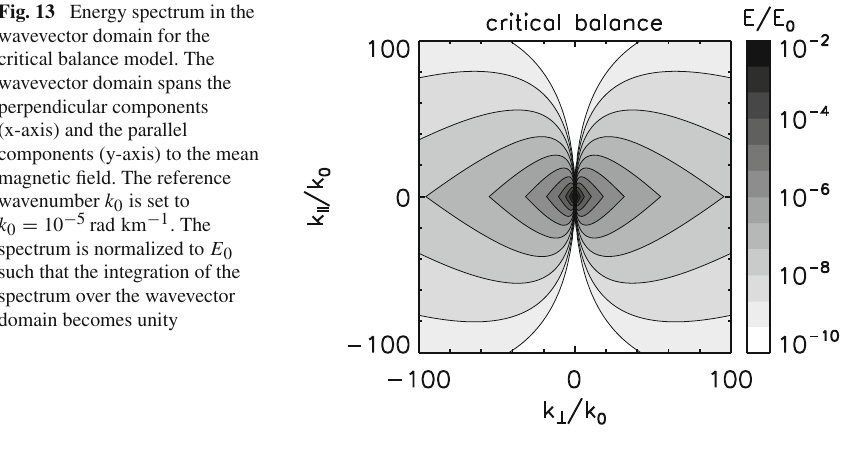
Fig. 13 Energy spectrum in the wavevector domain for the critical balance model. The wavevector domain spans the perpendicular components (x-axis) and the parallel components (y-axis) to the mean magnetic field. The reference wavenumber k 0 is set to k 0 = 10 − 5 rad km − 1 .